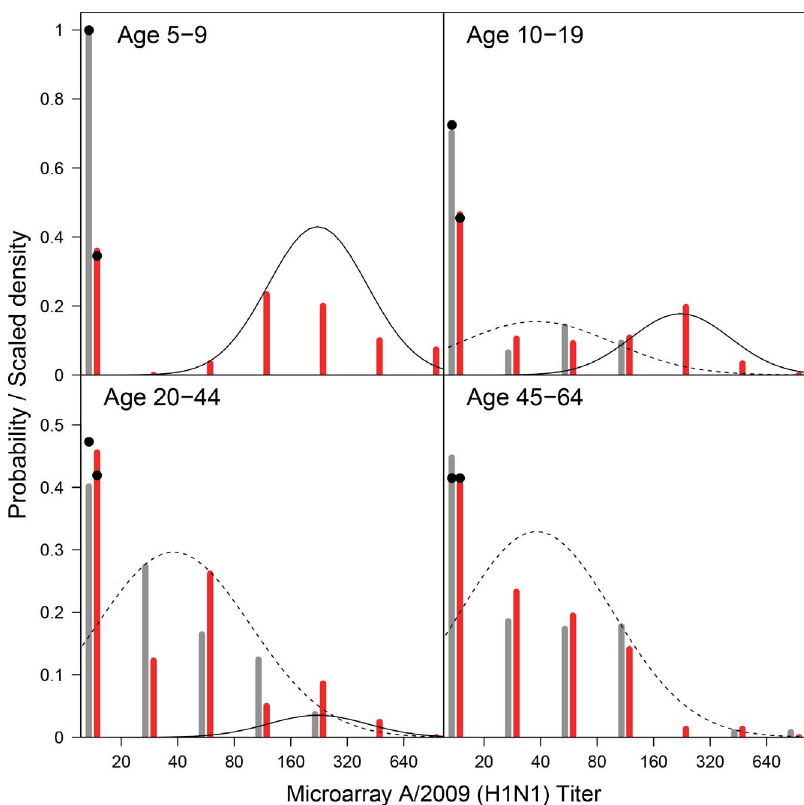
Figure 2. A/2009 (H1N1) microarray titers (bars) and the fitted mixture distributions (lines). The data are aggregated as follows: , 20, 20– 40, 40–80, 80–160, 160–320, and 320–640. Grey and red bars represent pre- and post-pandemic data, respectively. The solid and dashed line represent the immune and infected component distribution, respectively. The cumulative probabilty density of the mixtures below the detection limit of 20 are marked with black dots.